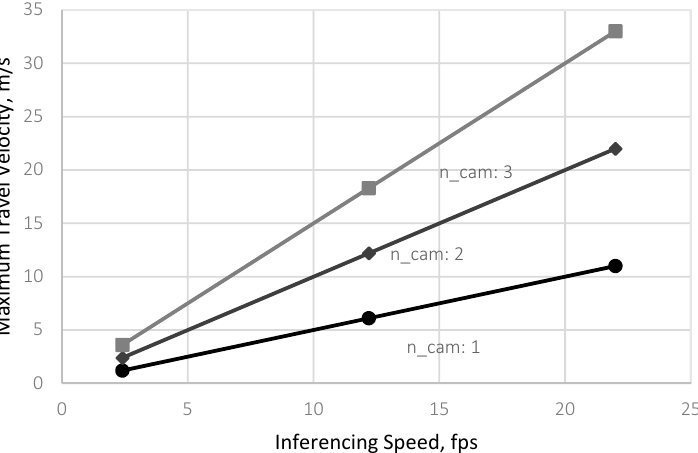
Figure 11. Theoretical maximum travel velocity to prevent missed detections with 1, 2, and 3 cameras at 2.4, 12.2, and 22.0 fps .